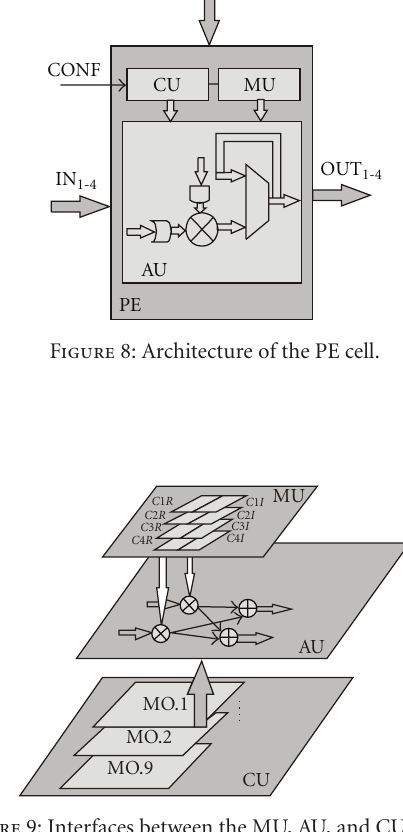
Figure 9: Interfaces between the MU, AU, and CU